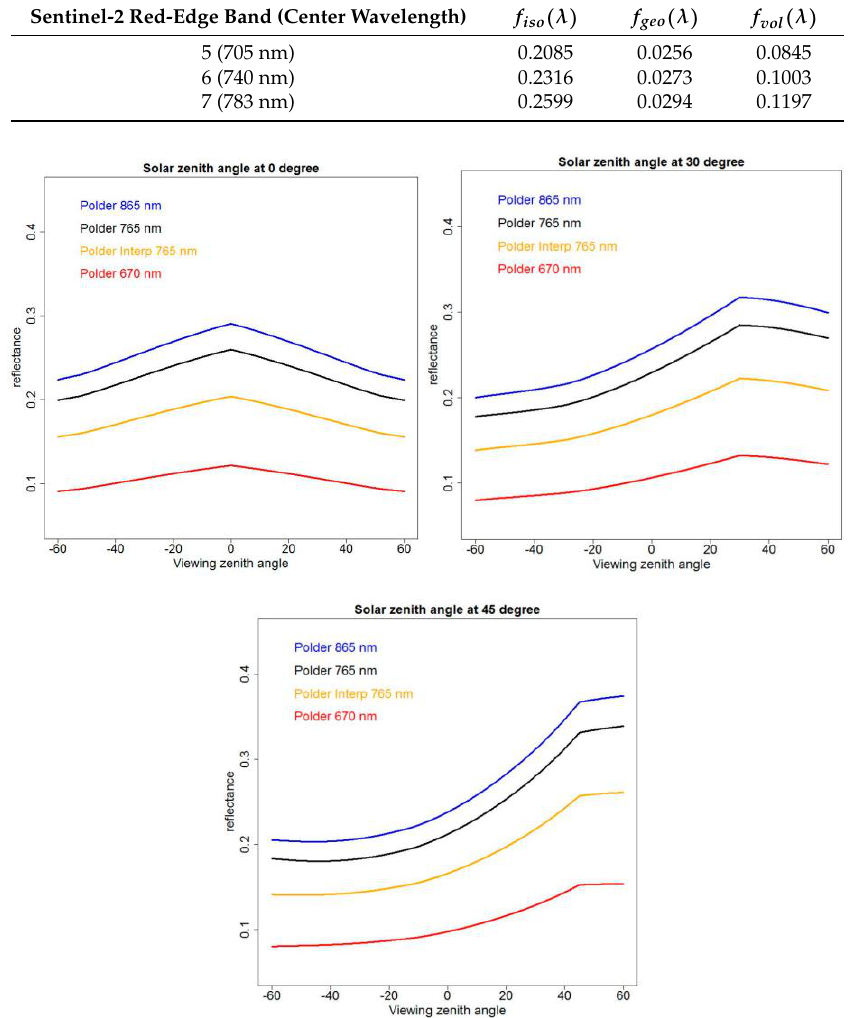
Figure 2. Predicted reflectance (derived as 1) using the fixed global annual POLDER NIR 865 nm (blue), red-edge 765 nm (black), and red 670 nm (red) BRDF model parameters (Table 2) and using the interpolated POLDER red-edge 765 nm (orange) BRDF model parameters. Shown for MODIS or POLDER ±60° view zenith angle range and for three fixed solar zenith angles (0°, 30°, 45°).